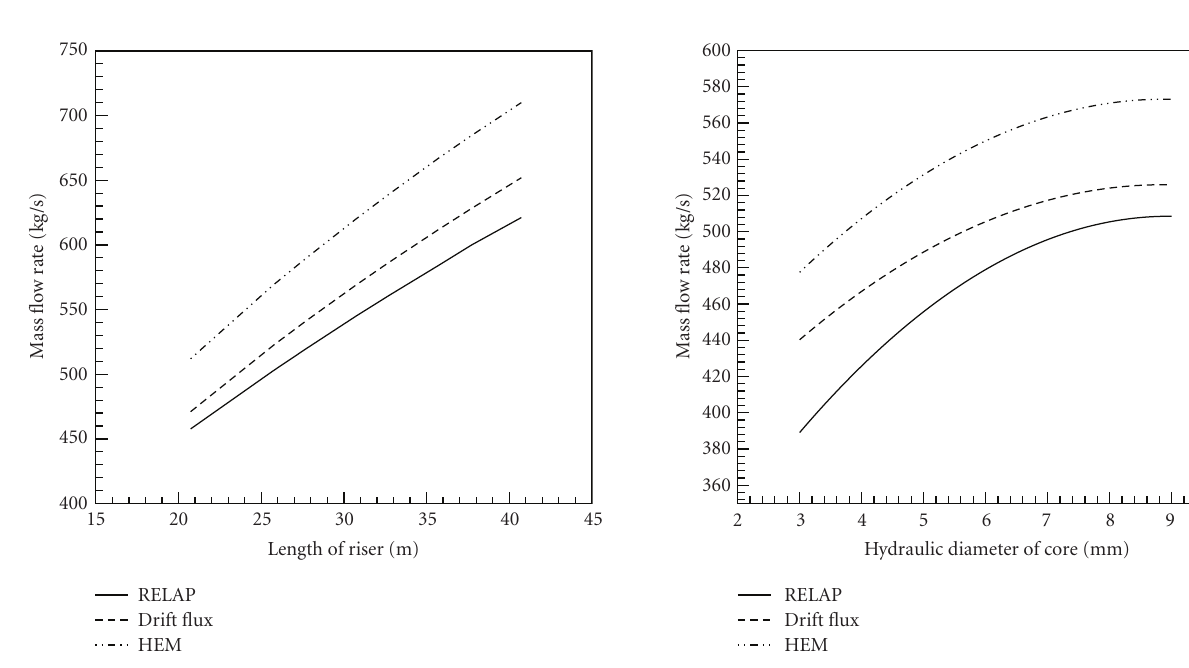
Figure 4: Variation of mass flow rate with riser length.